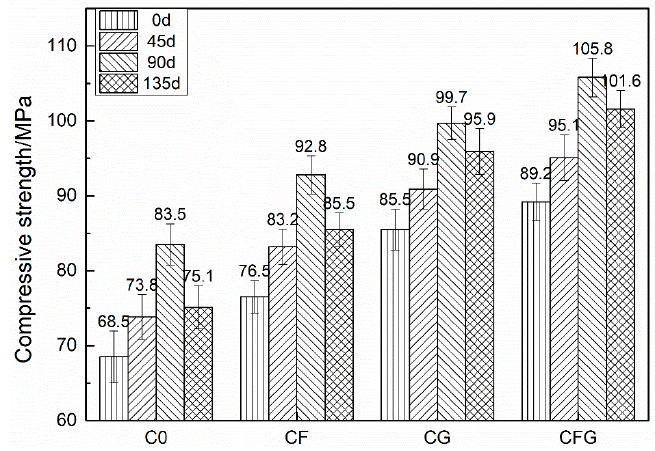
Figure 5. Compressive strength of samples under the sulfate corrosion condition.